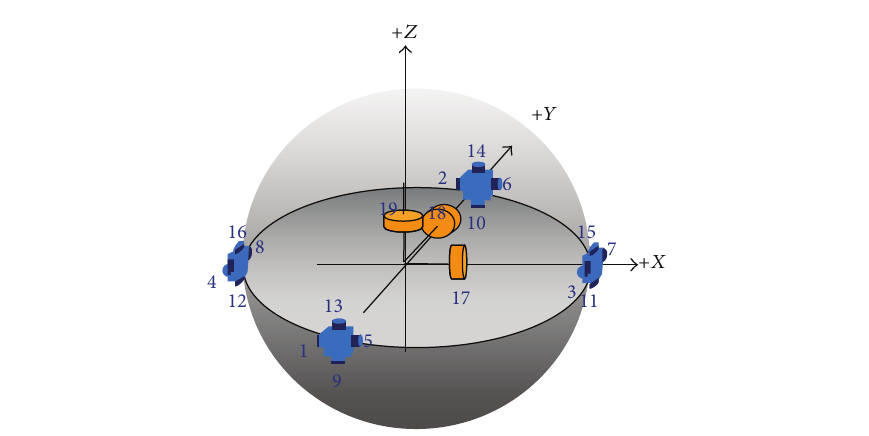
Figure 3: The Thrusters of Micro-SIM.